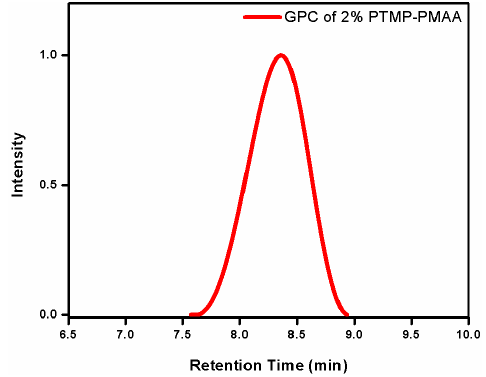
Figure 1. GPC (gel permeation chromatography) curve of the PTMP-PMAA obtained with 2% pentaerythritol tetrakis 3-mercaptopropionate (PTMP). Table 1. Molecular weight of 2% PTMP-PMAA.